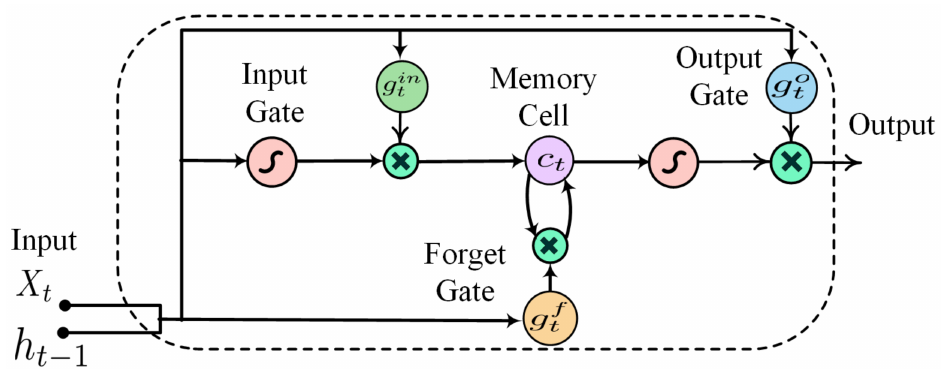
Figure 1. Basic structure of an LSTM memory